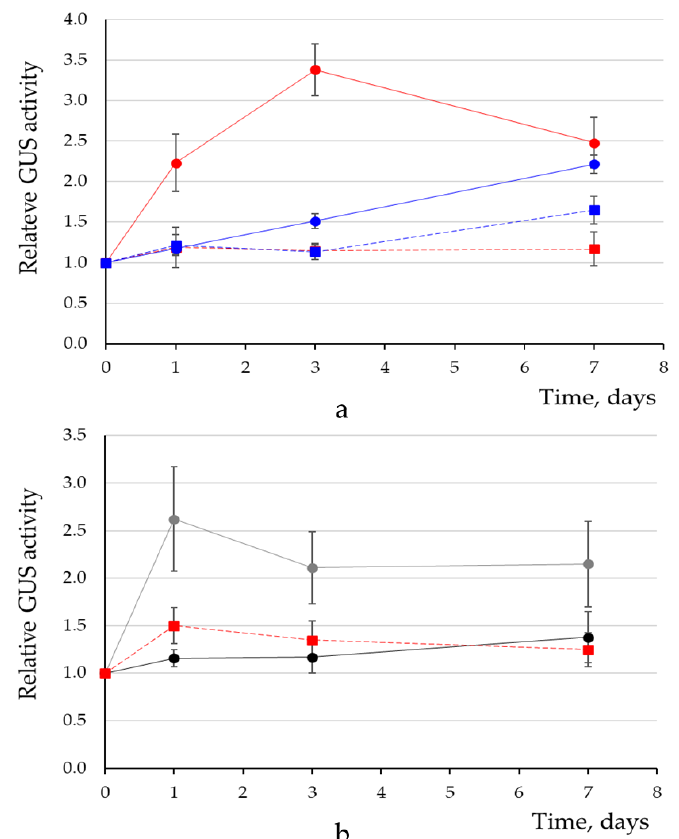
Figure 9. Relative GUS activity levels over time in the leaves of transgenic tobacco plants grown aseptically upon addition of 90 mM proline or sterile water (control). ( a ) Treatment with a freshly prepared proline solution of plants carrying the pro-SmAMP1 :uidA (proline—red circles, n = 16, control—red squares, n = 16) and the pro-SmAMP2 :uidA construct (proline—blue circles, n = 22, control—blue squares, n = 22). ( b ) Treatment of plants bearing the pro-SmAMP1: uidA construct by proline solution that had been stored for 5 months (gray circles, n = 12), or 10 months (black circles, n = 12), or by sterile water (red squares, n = 24). The plants were grown in a 16-h light / 8-h dark photoperiod. GUS activity in leaves before treatment was set to